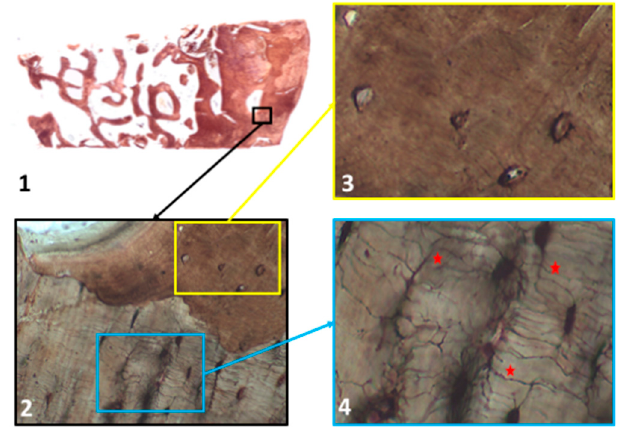
Figure 3. Undecalcified section of the bone specimen retrieved from the maxillary sinus. ( 1 ) whole sample; ( 2 ) detail of NFB inhabited by dendritic-like osteocytes with cell-to-cell contacts (red stars in